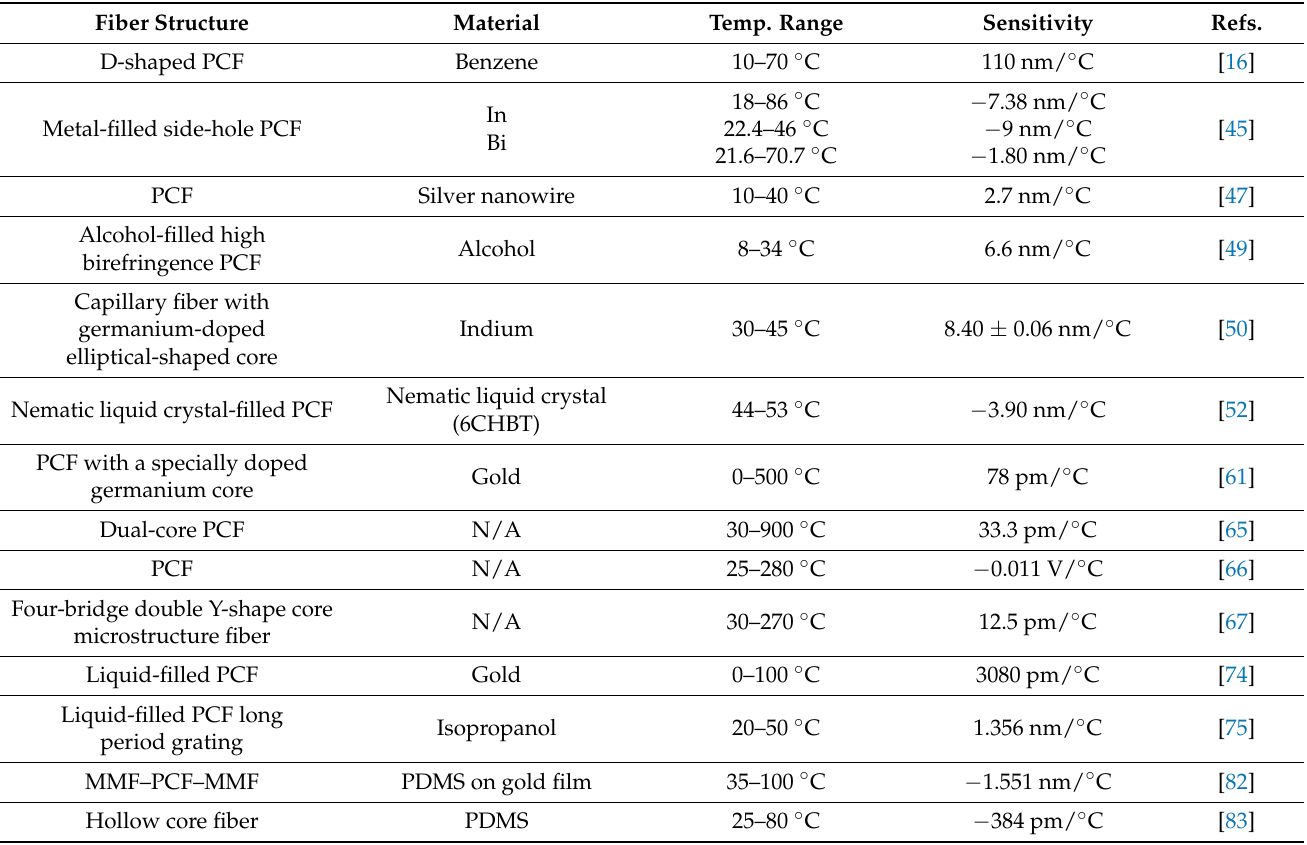
Table 1 summarized the different structures of the MOF with or without external material coating and selectively filled configuration used for temperature sensing. Table 1. Summary of MOF-based temperature